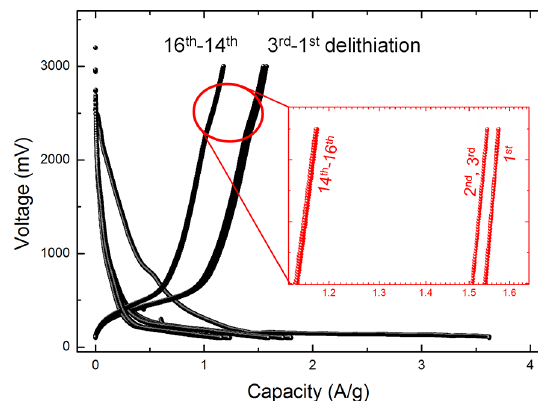
Figure 4. Galvanostatic delithiation/lithiation profiles of silicon nanowire electrode from n type 0.005 Ωcm wafer. Inset shows close up image of the red circled